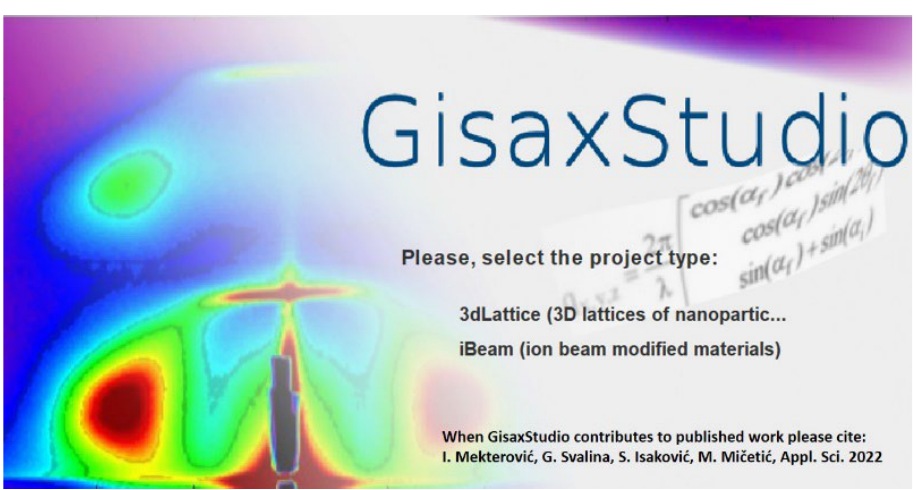
Figure 3. Starting window of GisaxStudio enabling the choice of the experiment type: the 3dLattice option should be used for the analysis of GISAXS from 3D ordered lattices of NPs , while iBeam is aimed at the analysis of NPs formed within ion-beam induced tracks.